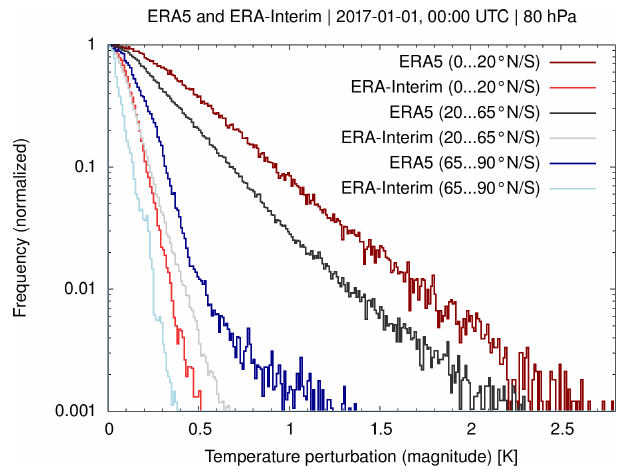
Figure 11. Normalized frequency distributions of ERA5 and ERA- Interim temperature fluctuations due to gravity waves on 1 January 2017, 00:00UTC, at the 80hPa level. The frequency distributions were calculated for the tropics, middle latitudes, and high latitudes, as separated at 20 and 65 ◦ N/S,